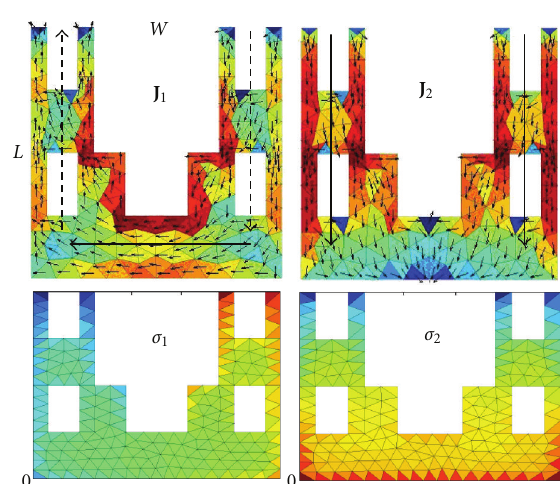
Figure 8: Fractional bandwidth FBW (VSWR < 2) for a R50 × 30 patch.